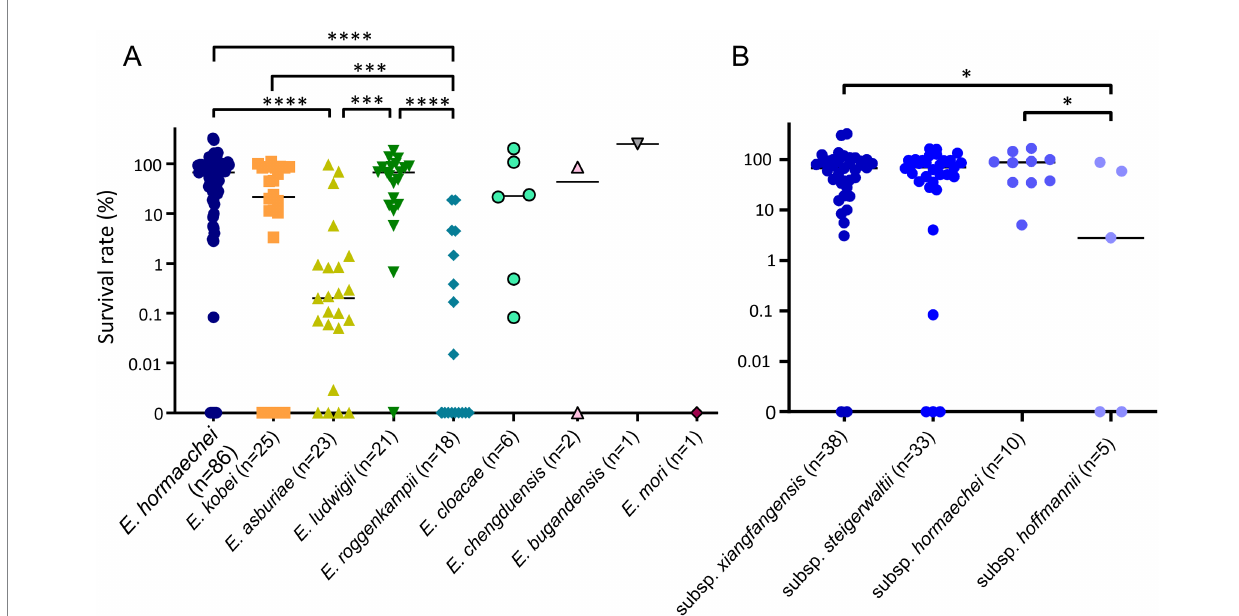
FIGURE 3 Results of serum bactericial assay among Enterobacter cloacae complex (ECC) species (A) and subspecies of Enterobacter hormaechei (B) . Bacterial survival rates were determined after 3 h of incubation with normal human serum (NHS). Heat-inactivated serum (HIS) was used as a negative control. * p < 0.05; *** p < 0.001; **** p <